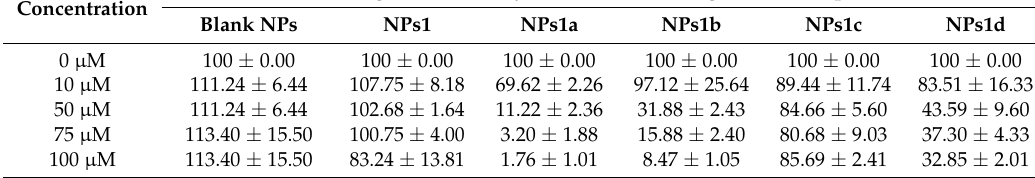
Table 6. Percentage cell viability (%) of MiaPaCa-2 against developed NPs. Concentration values are in µ M for NPs, and cell viability is expressed as mean ± SD. All values were obtained from three